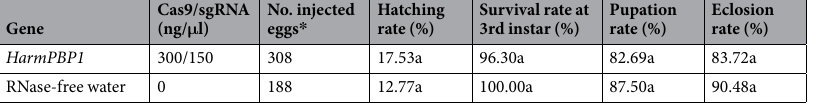
Table 2. Comparison in survival and development between Cas9/sgRNA injected and RNase-free water injected H. armigera eggs. * Includes the 20 eggs used for chimeric mutation analysis. Hatching rates were calculated on the larval number at the 4th day after injection. Same letter indicates no significant difference between Cas9/sgRNA injected and RNase-free water injected eggs, by the Chi-square